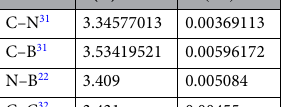
Indices i, j, and k specify the existing atoms in the ijk bond. rij and rik indicate the lengths of ij and ik bonds, respectively, with θijk being the angle between them. These coefficients have been used concerning the coef- ficients presented above. In the study of ballistic properties, for multilayered configurations, which is a non-bonded van der Waals interaction, the Lennard–Jones potential is used. The values of ε and σ can be seen using the following formulas in Table 1.